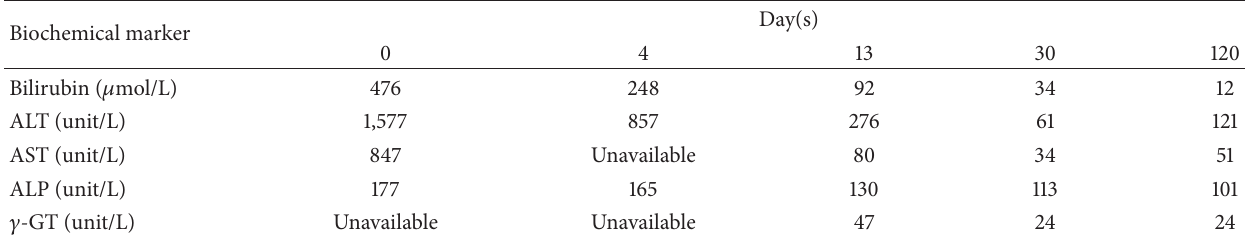
Table 1: Liver function test results showing a rapid improvement in biochemical markers over a four-month period. Results displayed from day 0 (admission) to 4, 13, 30, and 120 days after admission.